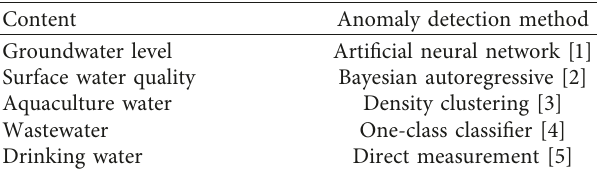
Table 1: Anomaly detection for different water